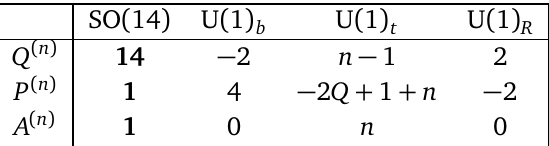
Table 5: The matter contents of the SO ( 14 ) × U ( 1 ) 2 model II and their charges. SO ( 14